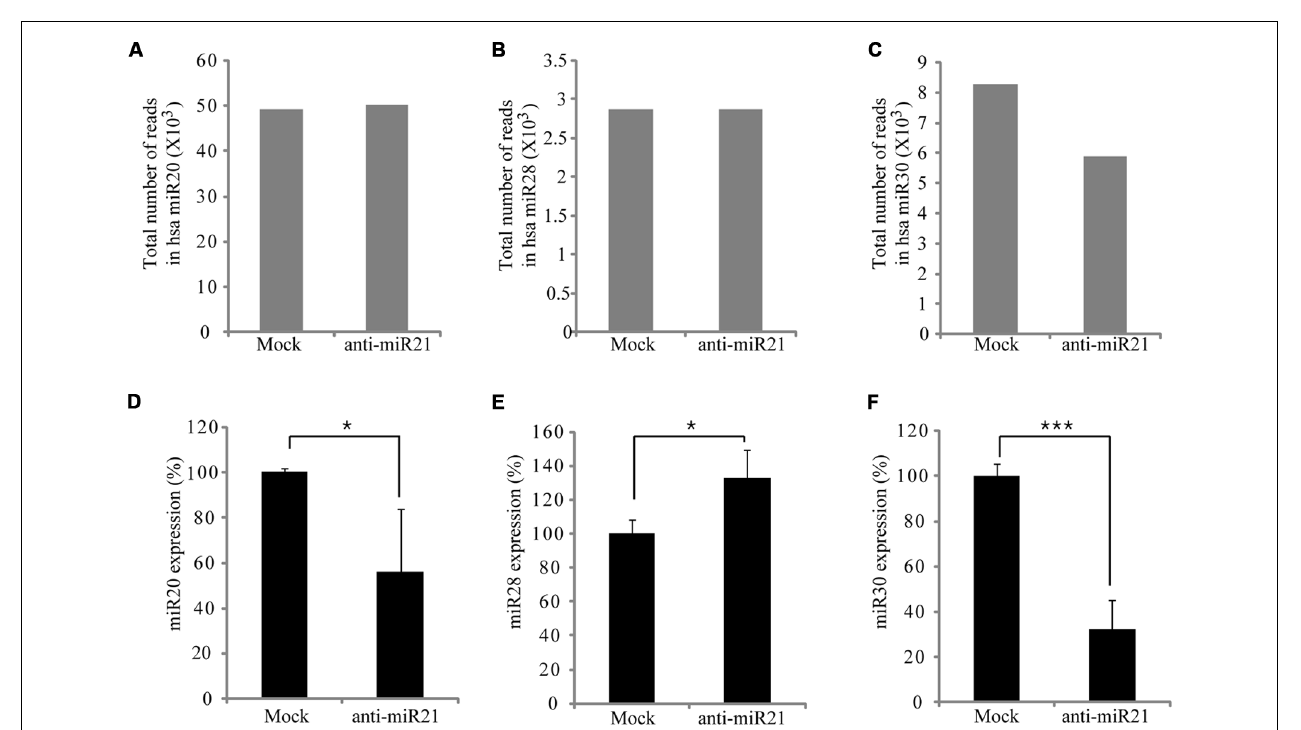
anti-miR21 or mock control. (C) Quantitative miR21 expression determined byTaqMan probe Q-PCR of HCT116-GFP cells transfected with anti-miR21 or mock control.Values represent mean ± SD ( n = 3) of three independent experiments.